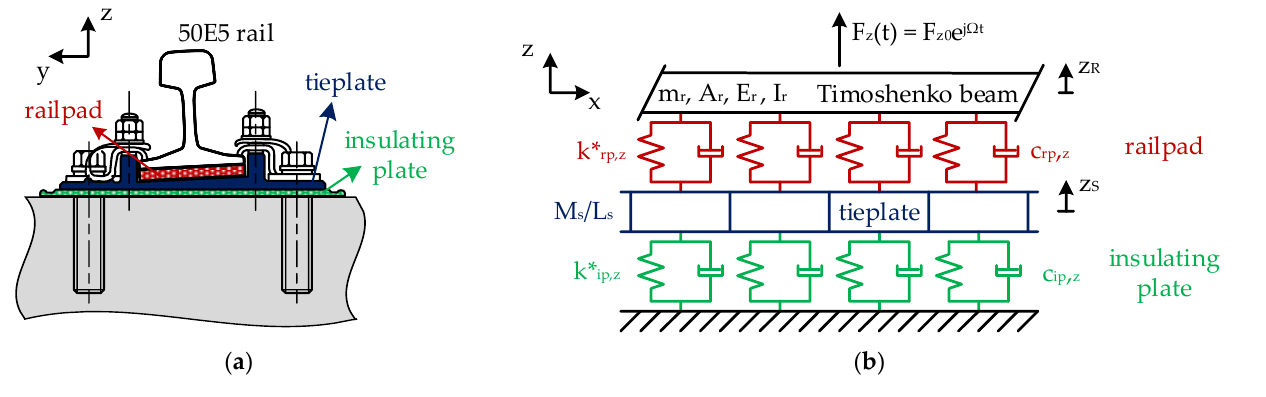
Figure 3. ( a ) Direct fastening system installed on the analysed track section; ( b ) scheme of the analytical track model. The explanation of * is given in Equation (12).